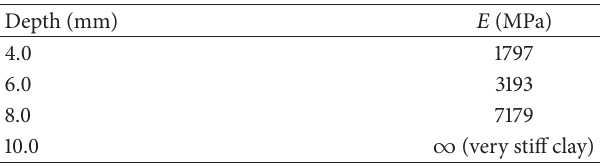
Dimensions of neoprene bearings are 300/400/100 mm. For Table 3: Modulus 𝐸 for layered soil model.